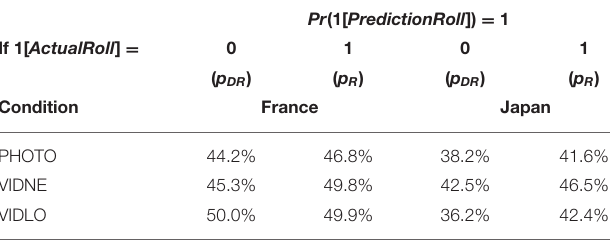
TABLE 2 | Predicted vs. actual behavior: prediction accuracy across countries and